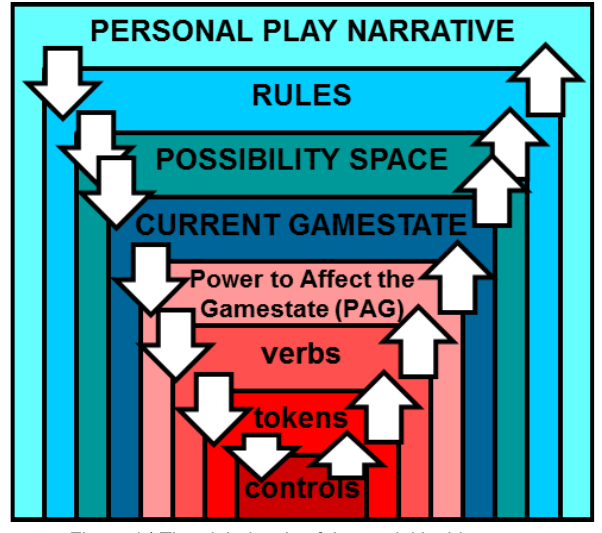
Figure 1 | The eight levels of the model in this